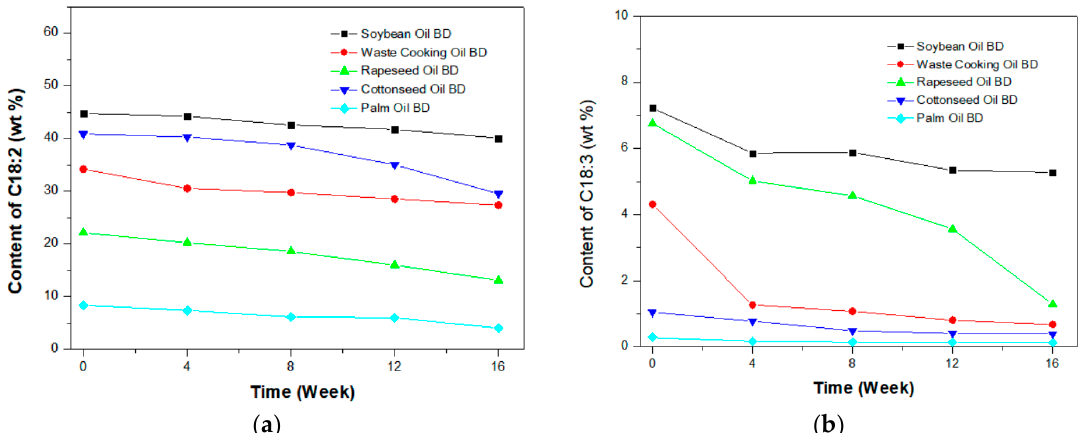
Figure 5 . Change in C18 FAMEs contents in BDs during accelerated oxidation. ( a ) C18:2 ME; ( b ) C18:3 ME.